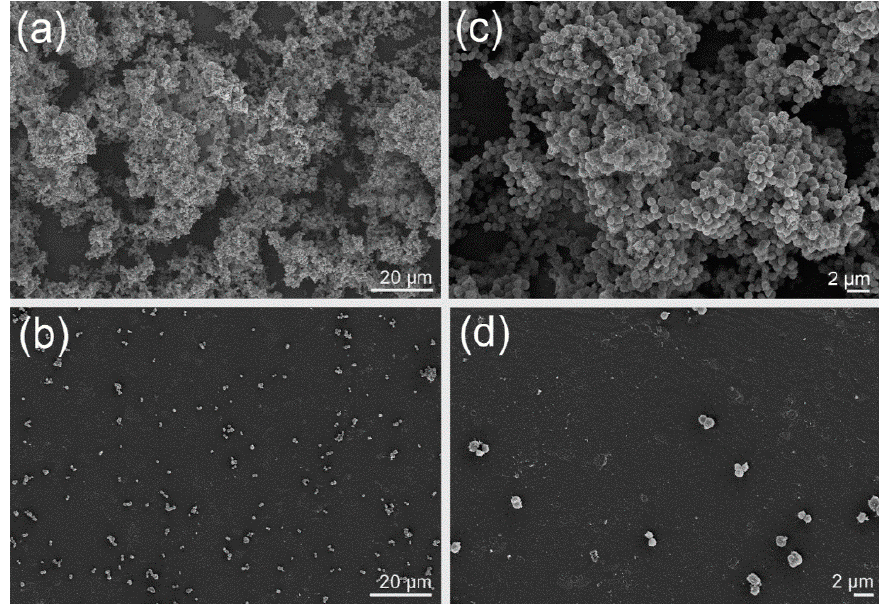
Figure 2. Field emission scanning electron microscopic (FESEM) images at di ff erent magnification steps ( b ) and ( d ) of Staphylococcus aureus biofilms treated with 64 µ g mL − 1 γ -linolenic acid (64 µ g mL − 1 ) compared to the negative control ( a , c ). Scale bar for ( a ) and ( b ) is 20 µ m, for ( c ) and ( d ) it is 2 µ m. Please note that in order to get a larger area covered with biofilm, 8-well plates were used here instead of the 96-well plates used for the determination of antibiofilm